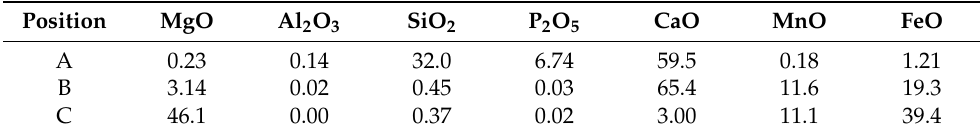
Table 2. Compositions of each phase in decarburization slag (mass%).